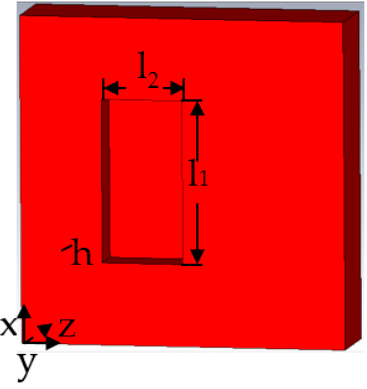
Figure 1. Three-dimensional model of rectangular Figure 1. Three ‐ dimensional model of rectangular defect.